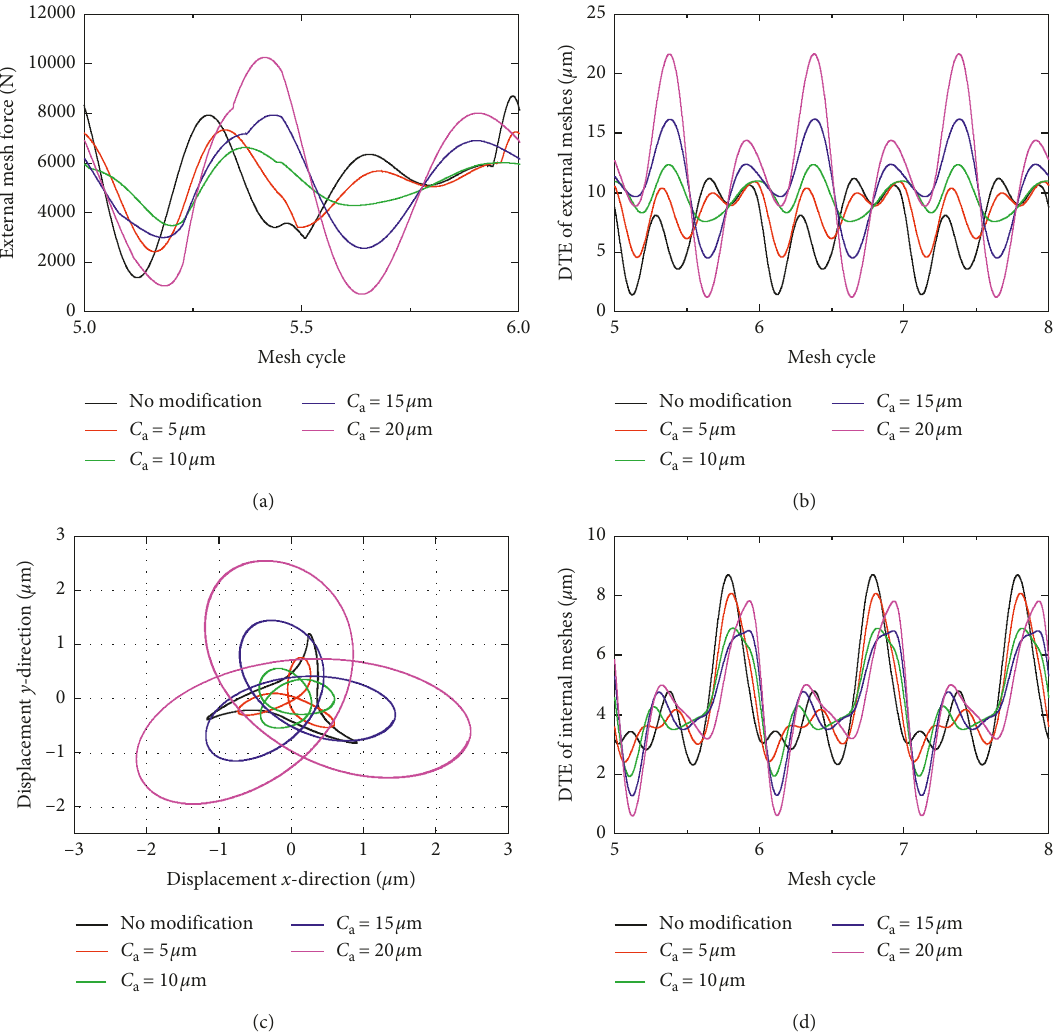
Figure 9: Dynamic responses for different amounts of TPM on external and internal meshes at sun-gear speed 6500rpm: (a) dynamic mesh force; (b) DTE of sun-planet meshes; (c) sun-gear trajectory; (d) DTE of ring-planet